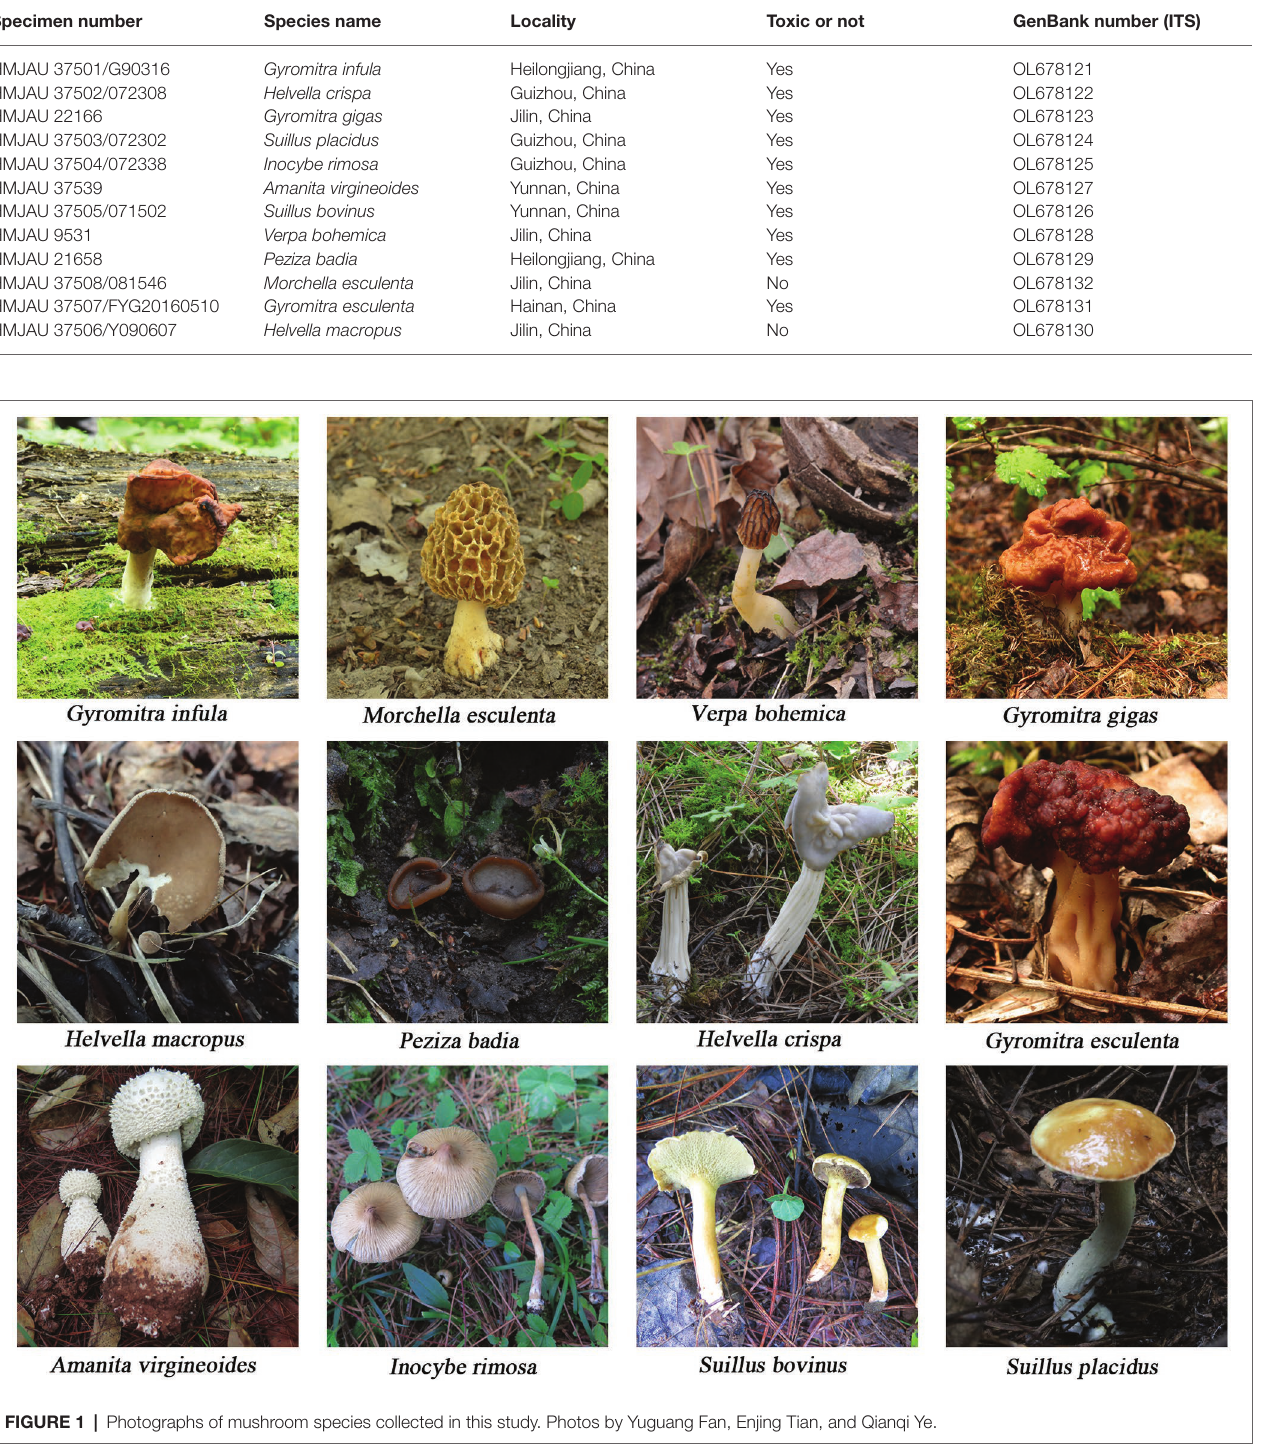
TABLE 1 | Information of mushrooms used in Gyromitra infula LAMP experiments.